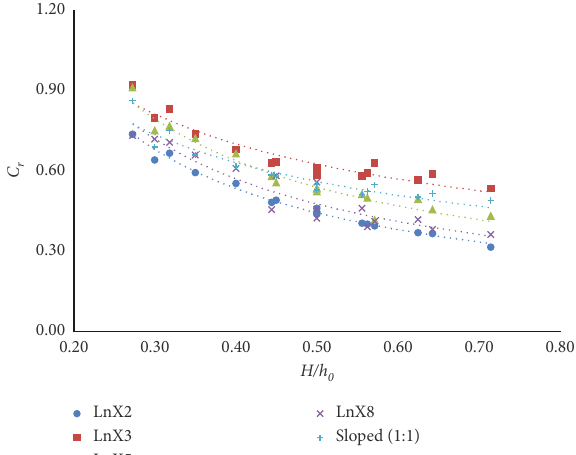
Figure 16: Model results of reflected wave height for logarithmic and sloped